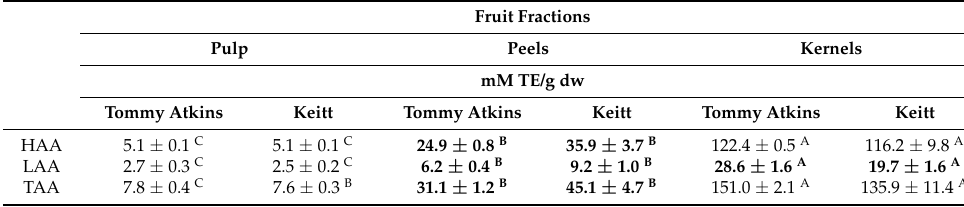
Table 3. Hydrophilic (HAA), lipophilic (LAA) and total (TAA) antioxidant activities in the pulp, peels and kernels of ripe mango fruits of the cultivars Tommy Atkins and Keitt. Fruit